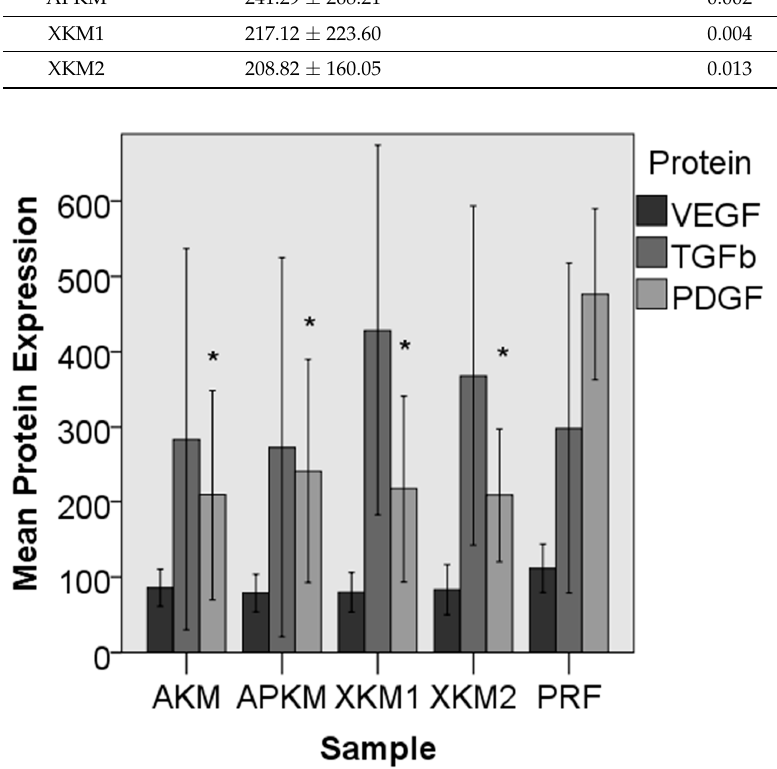
Figure 4. Expression of VEGF, TGF, and PDGF in the BSM samples incubated with PRF in comparison to PRF alone. PDGF was statistically significantly decreased for all tested BSMs in comparison to PRF alone (* p < 0.05; for detailed p -values, please refer to the text). SEM micrographs showed the BSM surfaces narrowly covered with a thin PRF-layer that is created by closely networked fibrin fibers demonstrated the closest spatial rela- tionship between BSMs and PRF (Figure 5).